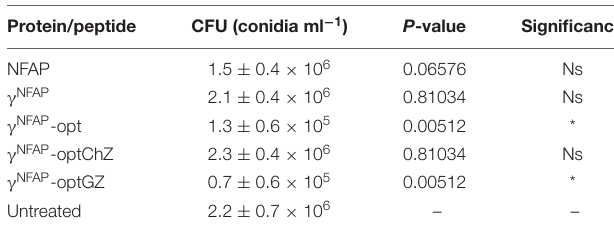
TABLE 3 | Colony-forming unit (CFU) of Cladosporium herbarum FSU 1148 conidia treated with 100 µ g ml − 1 Neosartorya fischeri antifungal protein (NFAP), γ NFAP -opt, and γ NFAP -optGZ